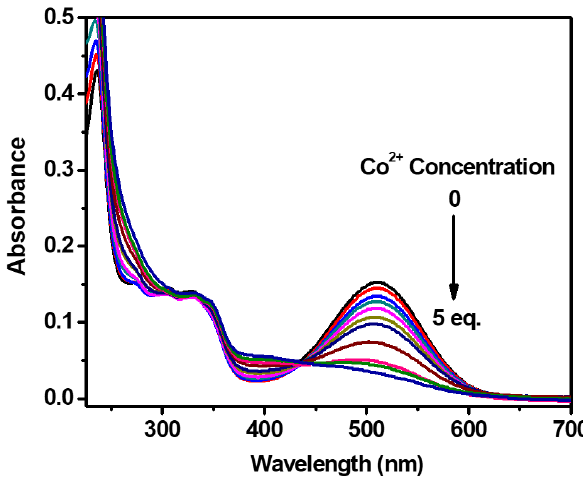
Figure 4. Changes in the UV-Vis spectra of L (1.0 × 10 − 5 mol L − 1 ) in CH 3 CN / HEPES (4 / 1, v / v , pH = 7.4) upon titration by Co 2+ from 0.5 × 10 − 5 mol L − 1 to 5.0 × 10 − 5 mol L − 1 at room temperature.